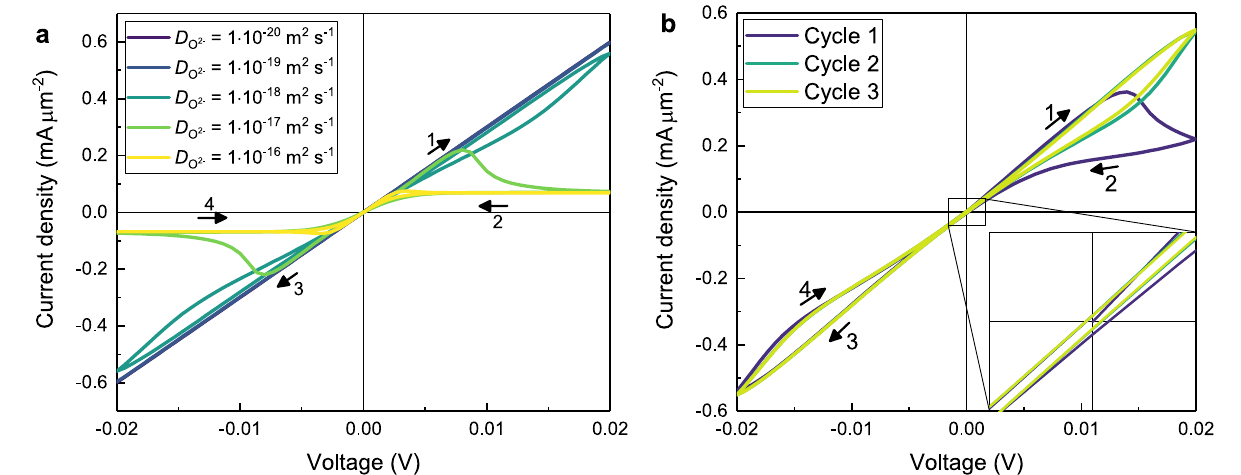
Figure 4. I–V curves for the variation of the diffusion coefficient D O 2 − in 1D with all other parameters fromTable 1. ( a ) Variation of the diffusion coefficient over five orders of magnitude. ( b ) Simulation with a